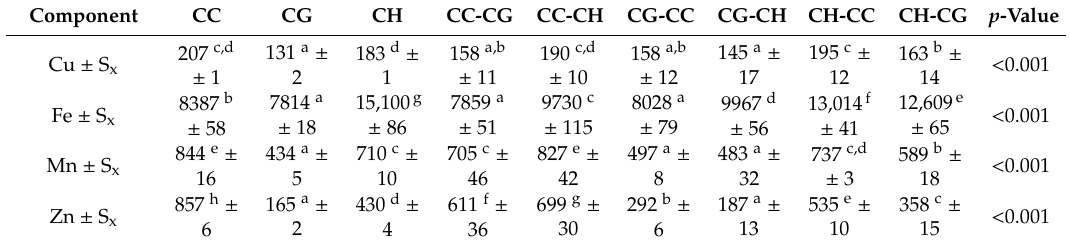
Table 3. Microelements content in ashes from the examined biomass.